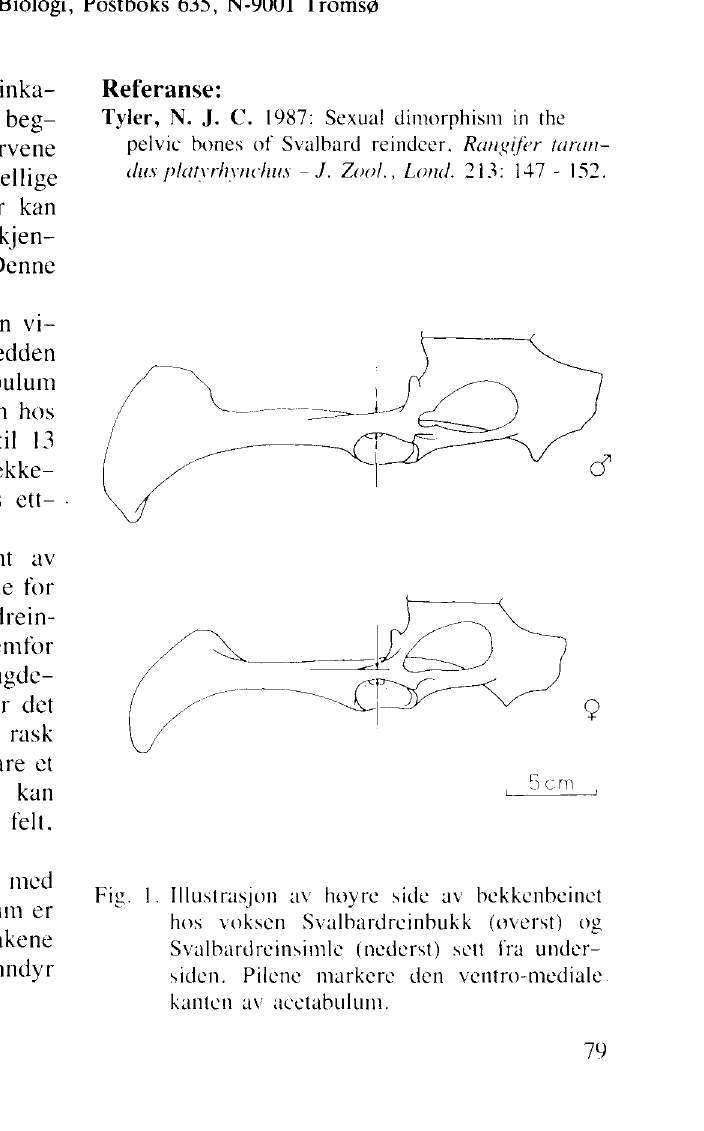
Fig. 1. Illustrasjon av høyre side av bekkenbeinet hos voksen Svalbardreinbukk (øverst) og Svalbardreinsimle (nederst) sett fra under siden. Pilene markere den ventro-mediale kanten av